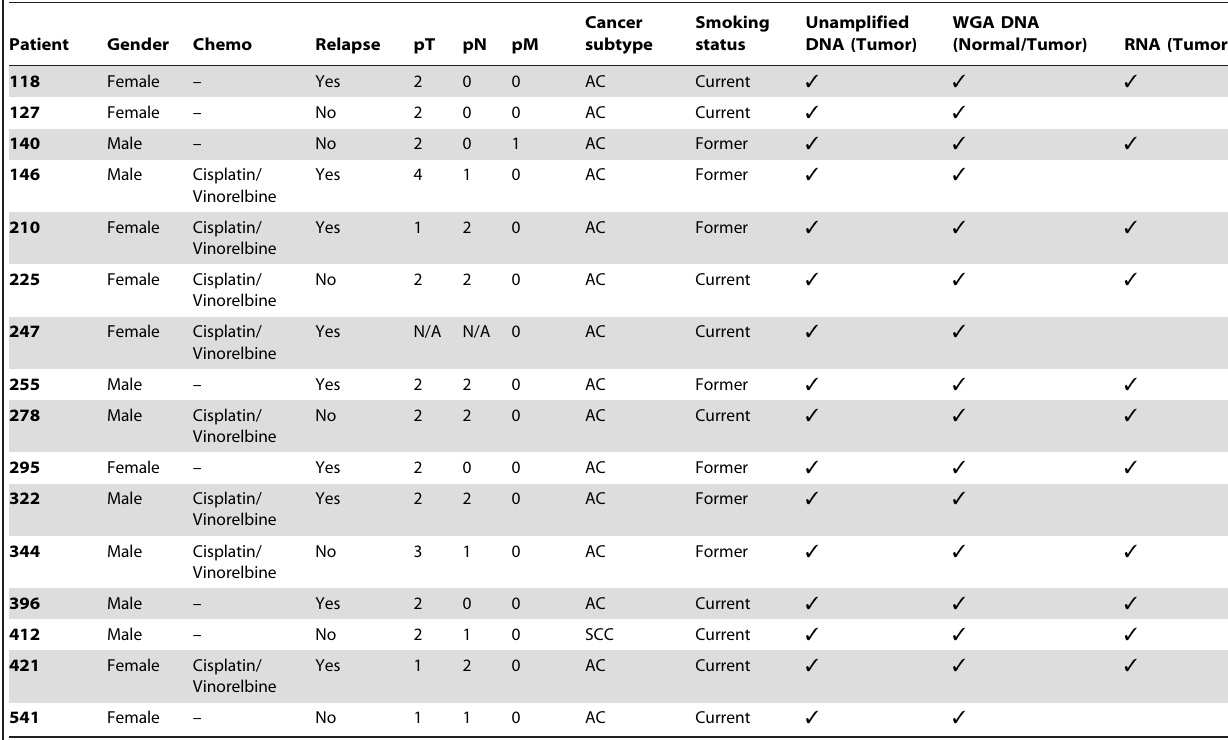
Table 1. Patient